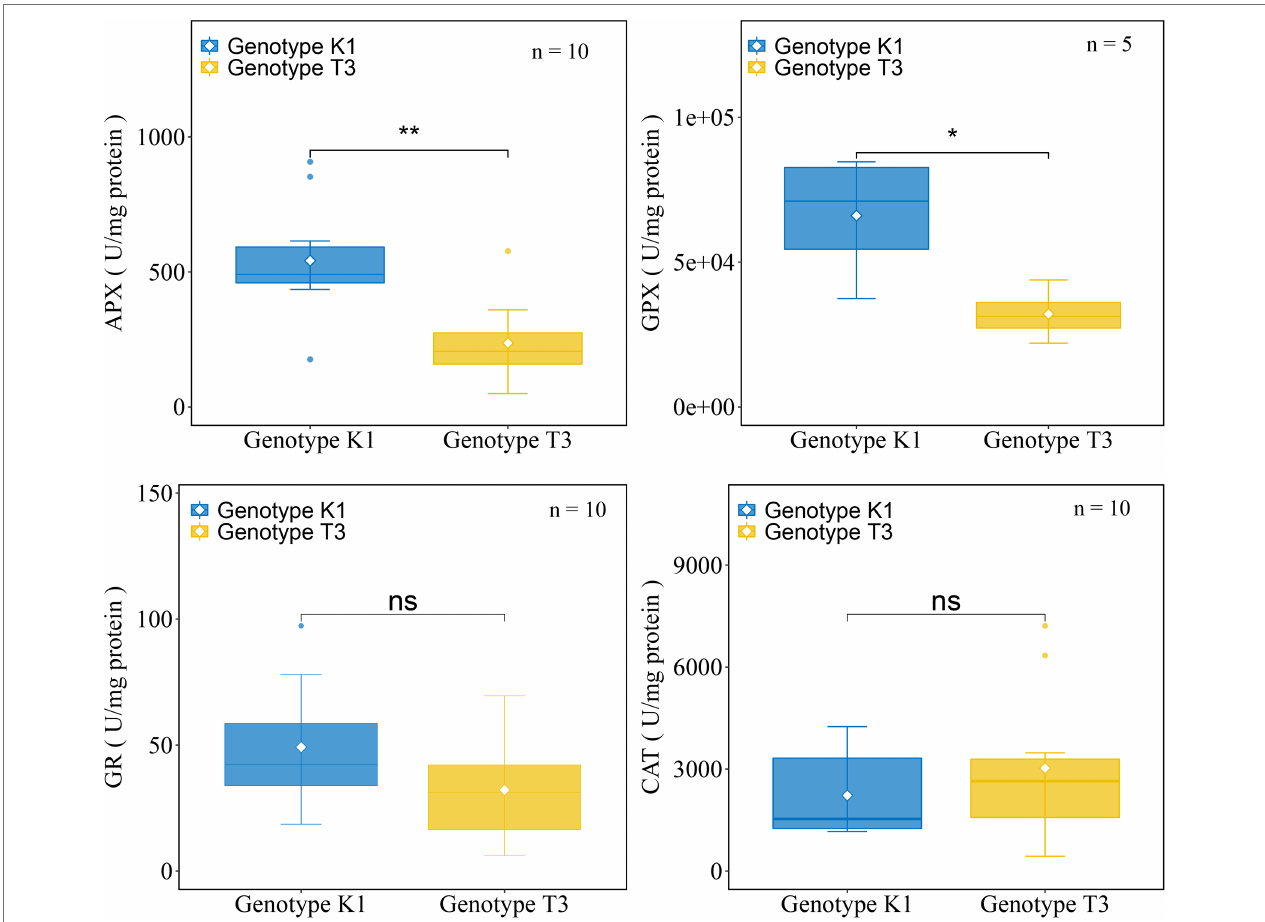
FIGURE 7 | The activity of ROS scavenging enzymes in leaves of Kreuzkogel 1 (K1) and Tenno 3 (T3) without B. cinerea inoculation. Significant differences between two genotypes, based on a t -test, are represented by ns p > 0.05, * p < 0.05 and ** p < 0.01. The individual points represent the outliers. APX, ascorbate peroxidase; GPX, glutathione peroxidase; GR, glutathione reductase; CAT,